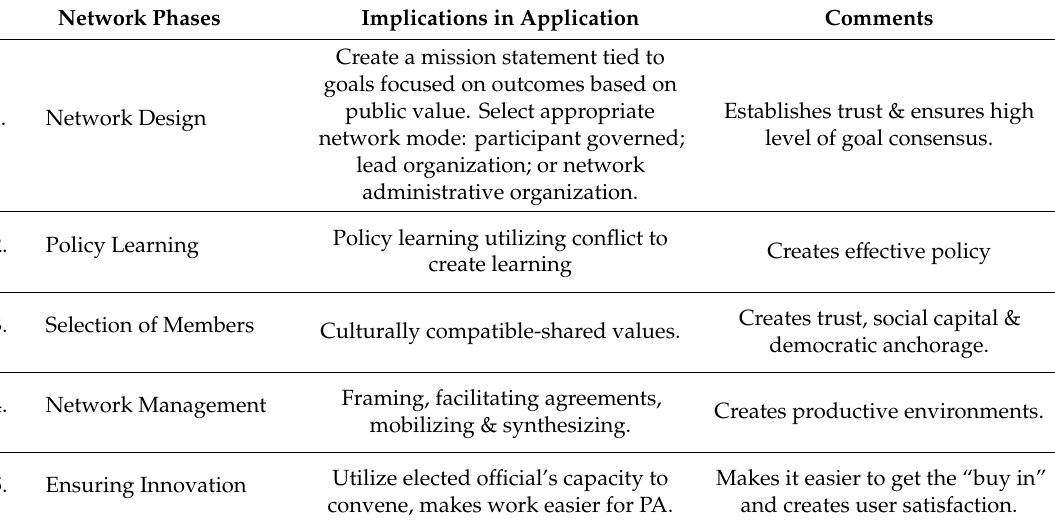
Table 1. Phases in Building